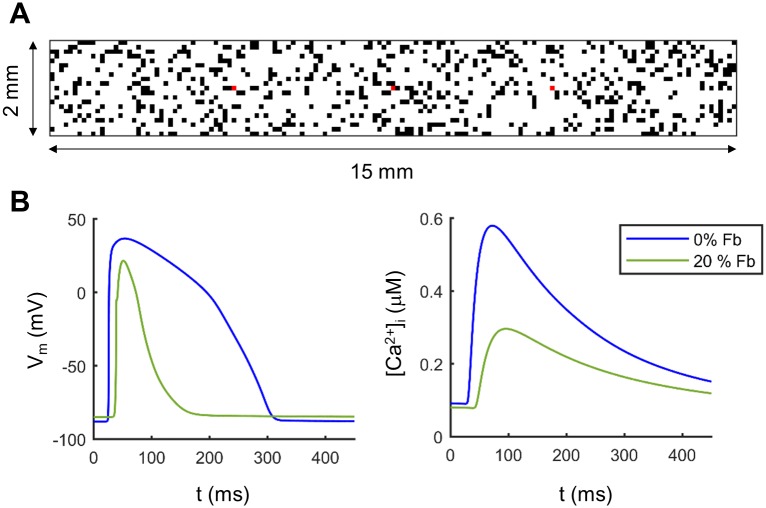
Electrophysiology in cardiac tissue simulations.A) Distribution of fibroblasts (20%; black squares) in a tissue of myocytes. Each square represents a node of the mesh and measurement nodes are marked in red. B) Action potential (AP) and calcium transient (CaT) waveforms obtained in the central node of the tissue without fibroblasts by stimulating at 1.25 Hz (blue traces) and with 20% of fibroblasts (green traces).